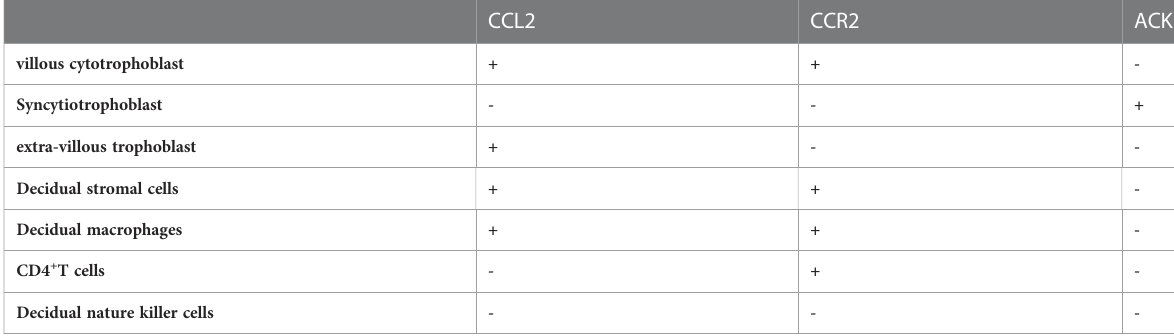
TABLE 1 The expression of CCL2/CCR2 at the maternal-fetal